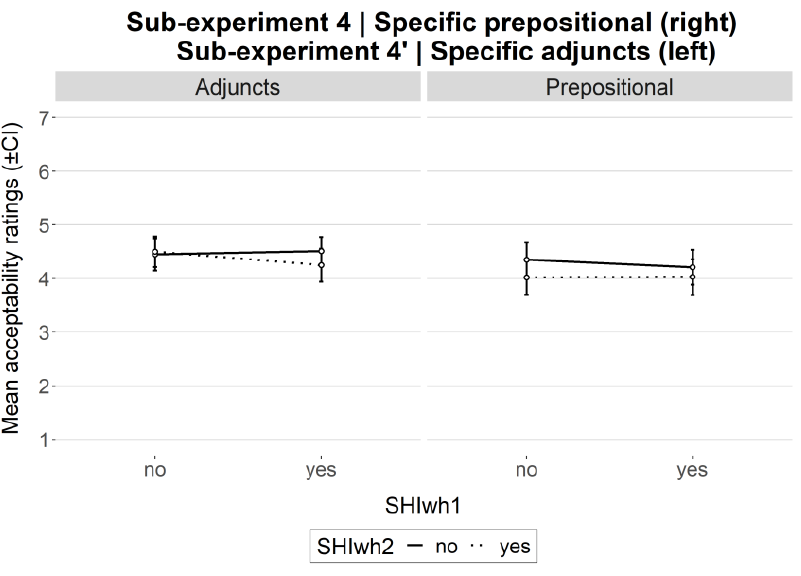
Figure 5. Mean acceptability ratings (n = 25). Error bars show 95% confidence interval. Table 12. Cumulative link mixed model fitted with the Laplace approximation. (Sub-experiment 4 | | Specific-Prepositional.)